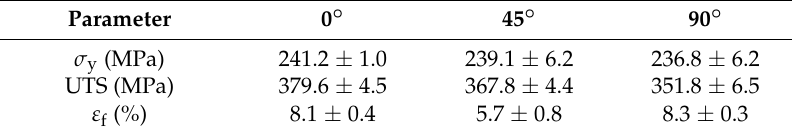
Table 3. Results of the quasi-static tensile tests of AlSi10Mg specimens.